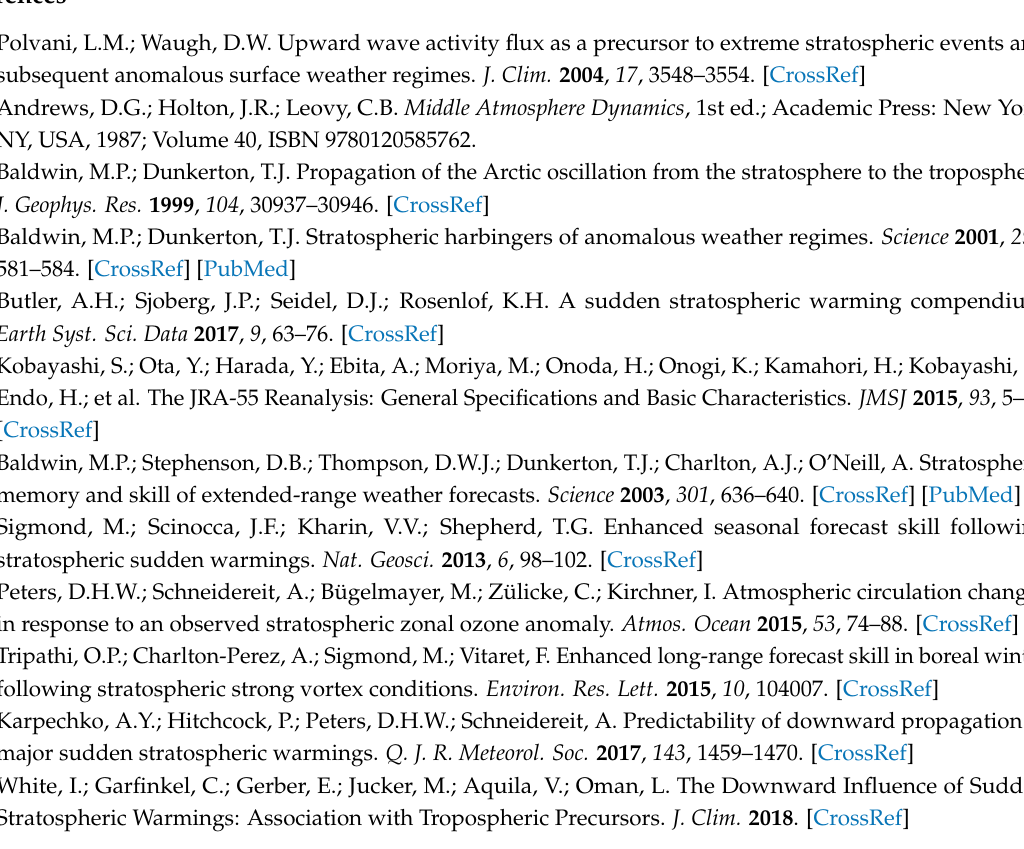
Table ST1: ERA-Interim, period 1979–2017, event numbers of NAM, CD and PJO diagnose, Table ST2: CMIP5-ESM-LR, period 1950–2005, LR-1 run, event numbers of NAM, CD and PJO diagnose, Table ST3: CMIP5-ESM-LR, period 1950–2005, LR-2 run, event numbers of NAM, CD and PJO diagnose, Table ST4: CMIP5-ESM-LR, period 1950–2005, LR-3 run, event numbers of NAM, CD and PJO diagnose; Figure S1. The scheme shows the main subjects of this study, the cross-section of the climatological zonal mean zonal wind (ZMZW, blue contours) with the polar-night jet (m/s; PNJ(U)) and subtropical jet (m/s; SJ(U)), and the mean zonal mean temperature (K; T, red contours) for boreal winters.; Figure S2. Mean composites of surface pressure anomaly (Pa) for strong-PJO (a), non-PJO (b), and difference of strong-PJO minus non-PJO (c) for ERA-Interim during 1–15 days after CD. Thick black (green) line in (c) includes area of significant differences with student t-test of 80 % (90 %) confidence.; Figure S3. Same as Figure S2 for mean composites of geopotential height anomaly (m) at 1000 hPa during 16–75 days after